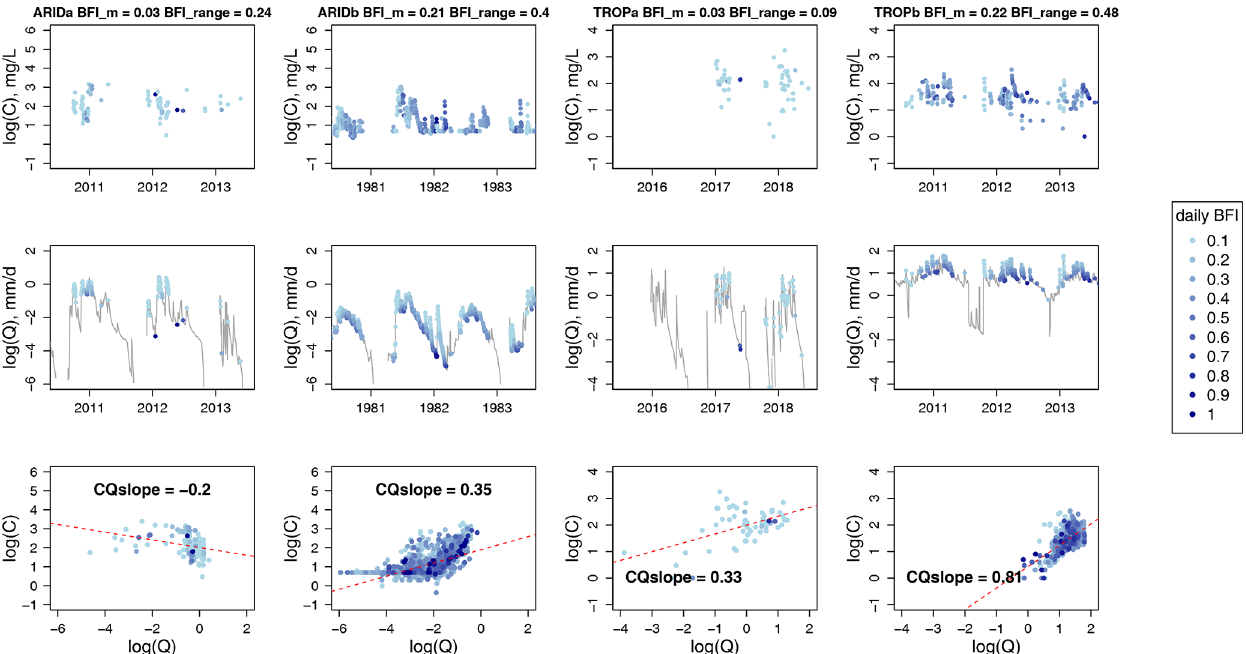
Figure 4. C – Q relationships between TSS and flow for four individual catchments (in columns), including two arid catchments (ARIDa, ARIDb) and two tropical catchments (TROPa, TROPb). Within each climate, two catchments with a low and high value of BFI_m are included. The BFI_m values along with the corresponding BFI_range values for individual catchments are shown in the column titles. The top and middle rows for each catchment show a 3-year time series within the records of TSS concentrations and the continuous records of flow, with dots showing the time steps of water quality samples. The bottom row shows the C – Q relationship with all matching TSS and flow data at each catchment. All data points are coloured according to the daily BFI, and all C – Q values are plotted on a log-10 scale. The dashed red lines represent the observed C – Q